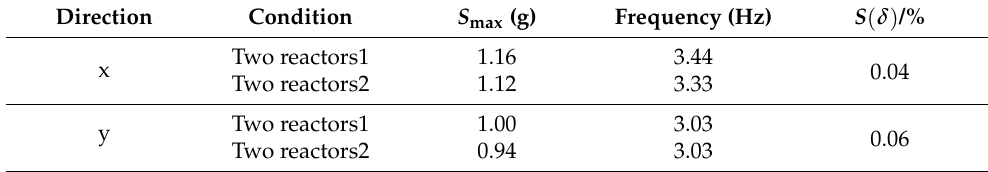
Table 12. Comparison of FRS at different locations of the raft foundation (2–10 Hz).